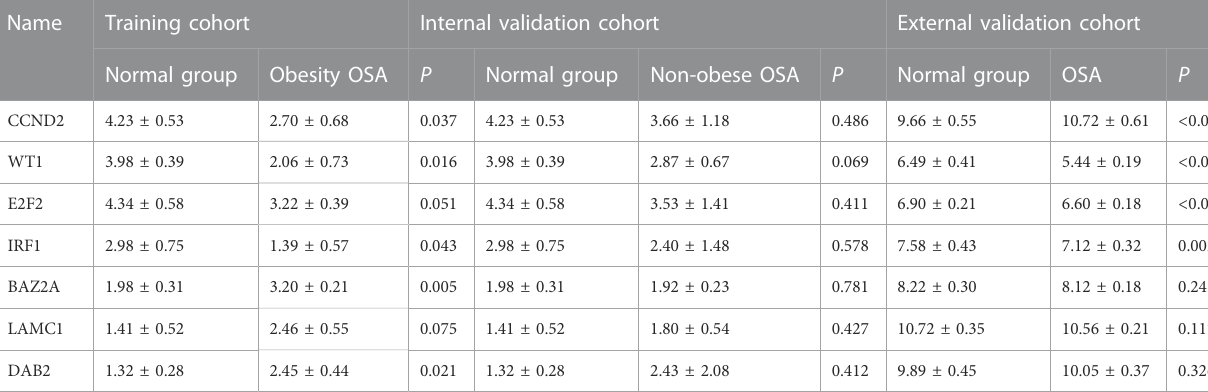
TABLE 3 Expression levels of hub genes of the study